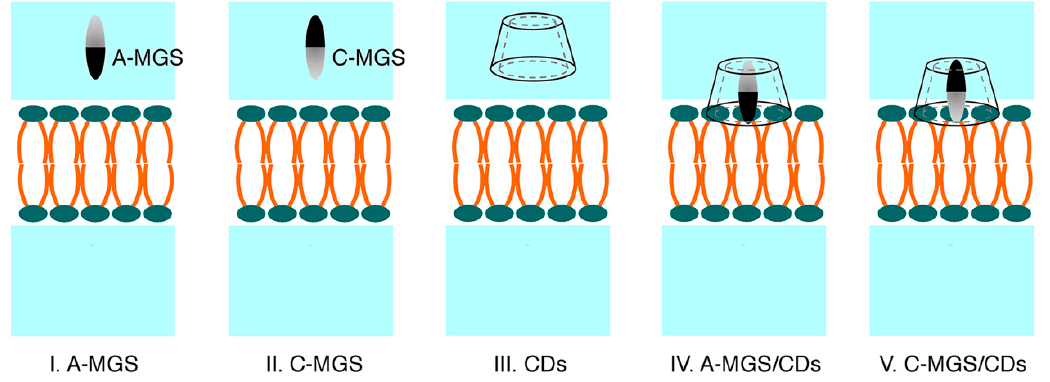
Figure 9. Illustration of the five studied models: (I) A-MGS, (II) C-MGS, (III) β CDs, (IV) A-MGS / β CDs, and (V) C-MGS / β CDs. Note that the A- and C-ring of MGS was represented by black and grey, respectively, whereas the β CDs ( β CD and DM β CD) served as the host molecules in this